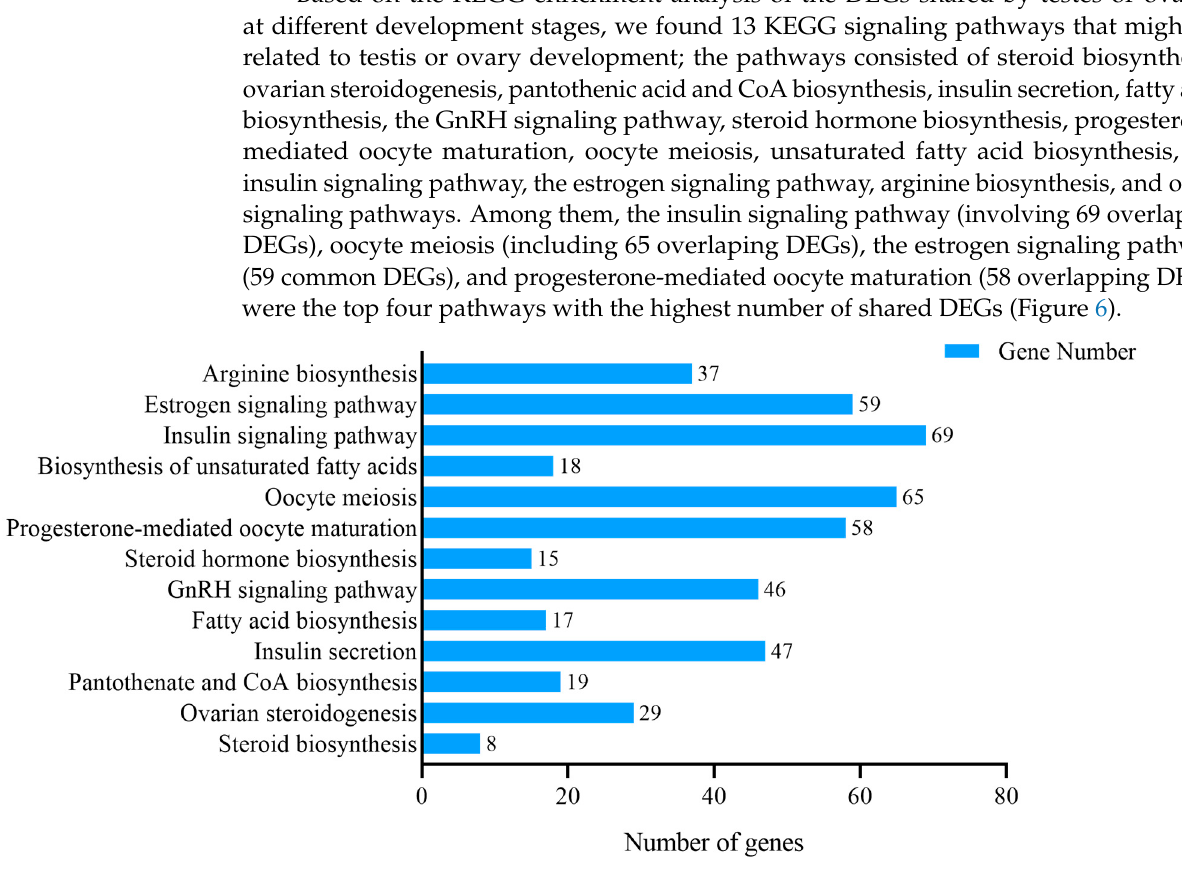
Figure 6. The 13 KEGG pathways that might be related to the regulation of gonadal development in Macrobrachium rosenbergii . The value next to each bar is the number of the enriched common DEGs.